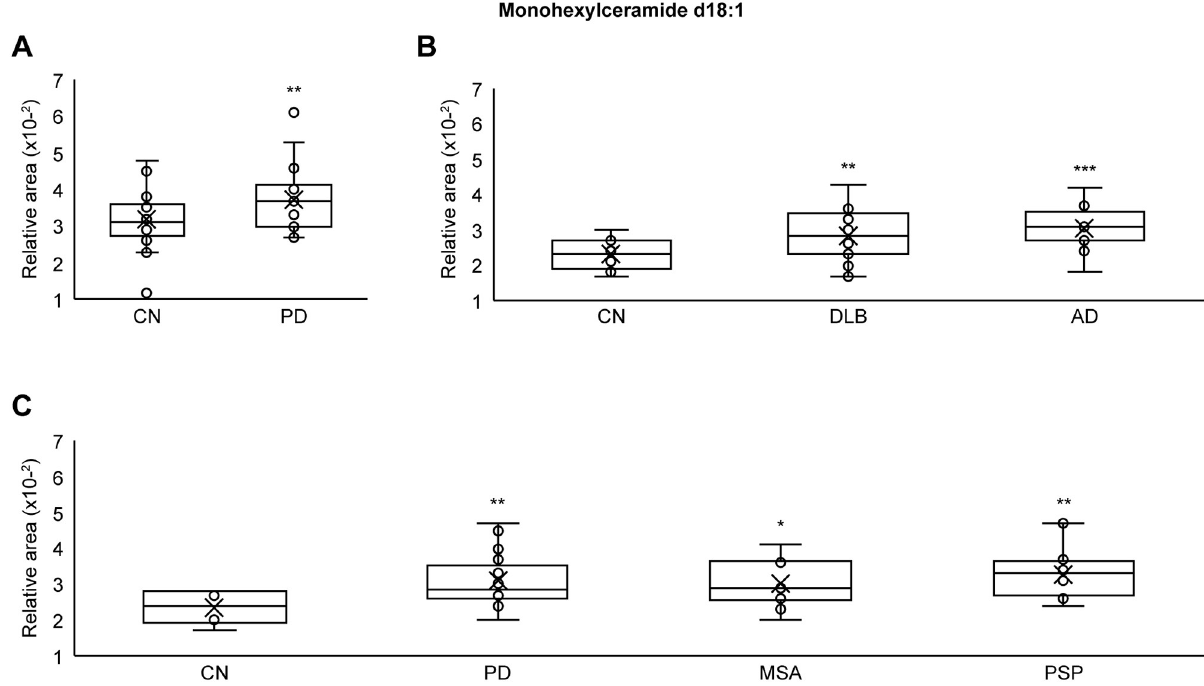
Fig 2. Plasma MonCer levels in neurodegenerative diseases. (A) Plasma MonCer d18:1 levels were significantly higher in the IPD group of cohort A (p < 0.01) than in the CN group. (B) Plasma MonCer d18:1 levels were significantly higher in the DLB group (p < 0.01) and AD group (p < 0.001) than in the CN group. (C) Plasma MonCer d18:1 levels were significantly higher in the IPD group of cohort C (p < 0.01), MSA group (p < 0.05) and PSP group (p < 0.01) than in the CN group. Statistical significance was examined using one-tailed Welch’s t tests (P < 0.05). Circles indicate the data points between the lower and upper whiskers, and x indicates the average marker in a box/whisker